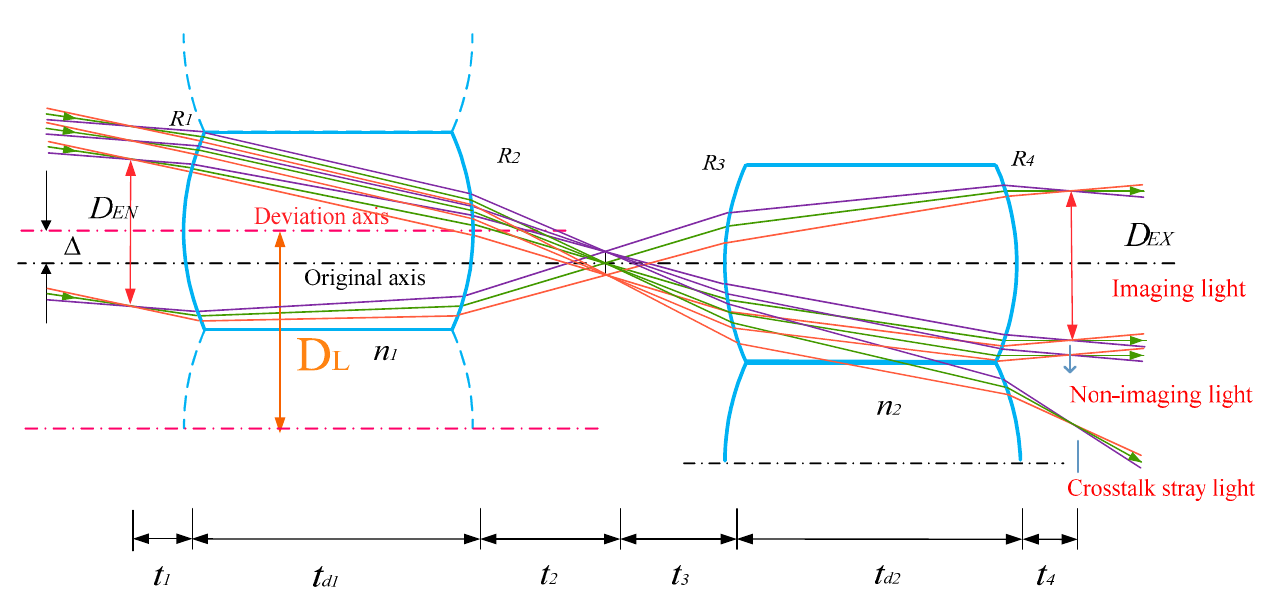
Figure 2. Schematic diagram of the crosstalk beam generated by the microlens array (green: SFOV, red: SFOV+IFOV, purple: SFOV-IFOV).